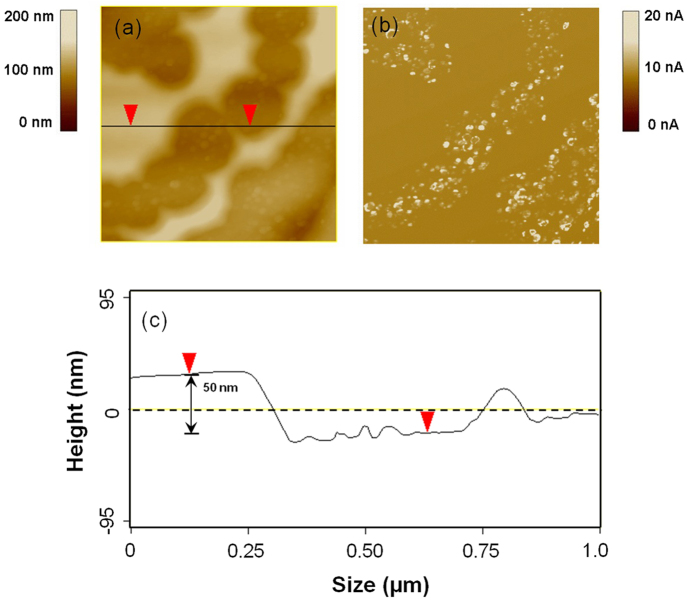
Surface topography (a), simultaneously measured current images (b), and cross-sectional view of surface topography (c) of the W crystal irradiated with a hydrogen fluence of 6.5 × 1024/m2. The current measurements were performed at Vtip = −20 mV.